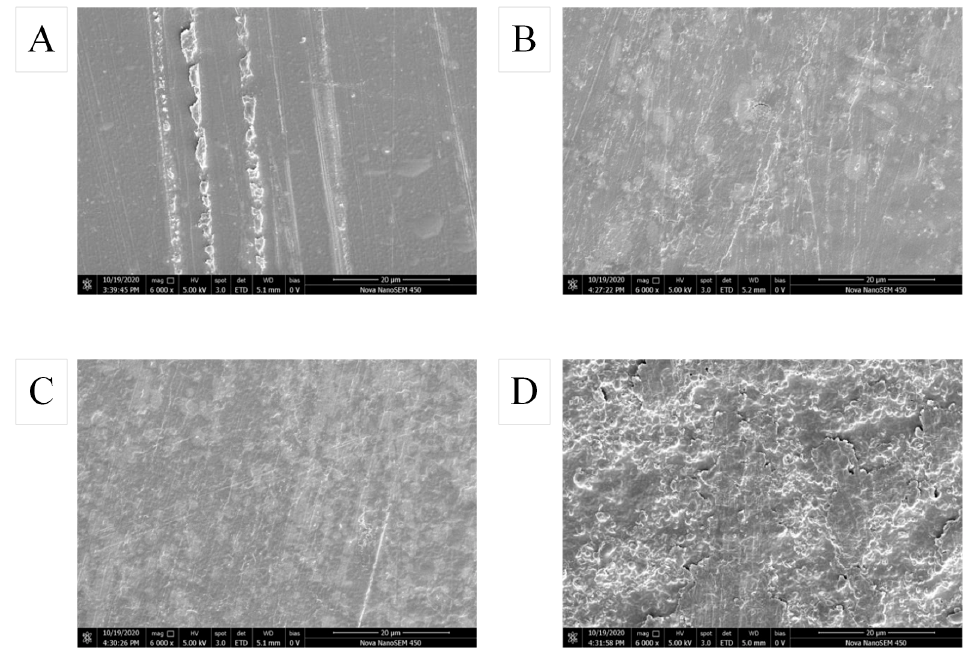
Figure 3. Effect of components on surface morphology of composite film ( A ) pure SA membrane; ( B ) SA/CW composite membrane; ( C ) SA/CW/G composite membrane; ( D ) SA/CW/G/Vc-Ca composite membrane.